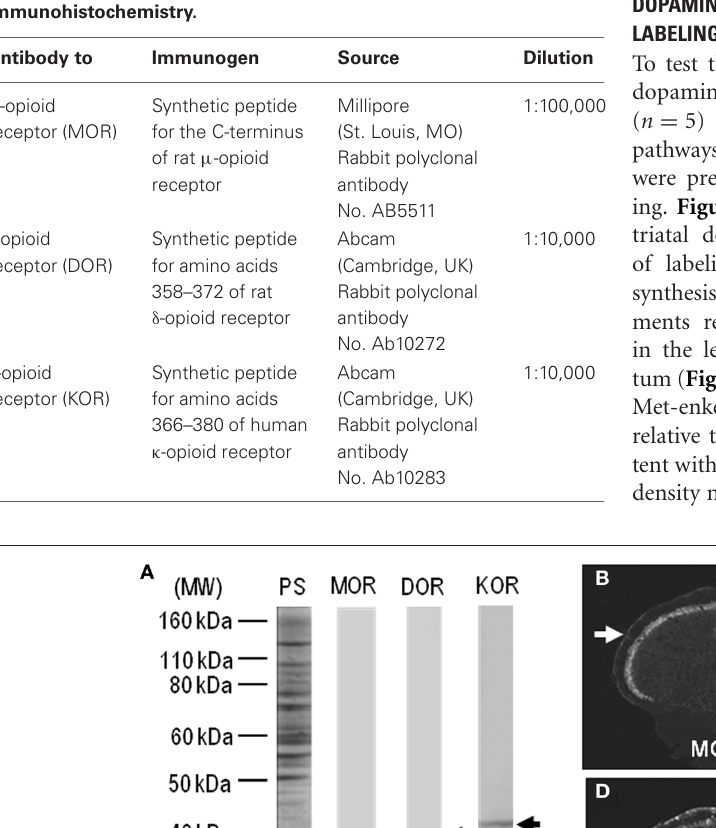
immunohistochemistry.